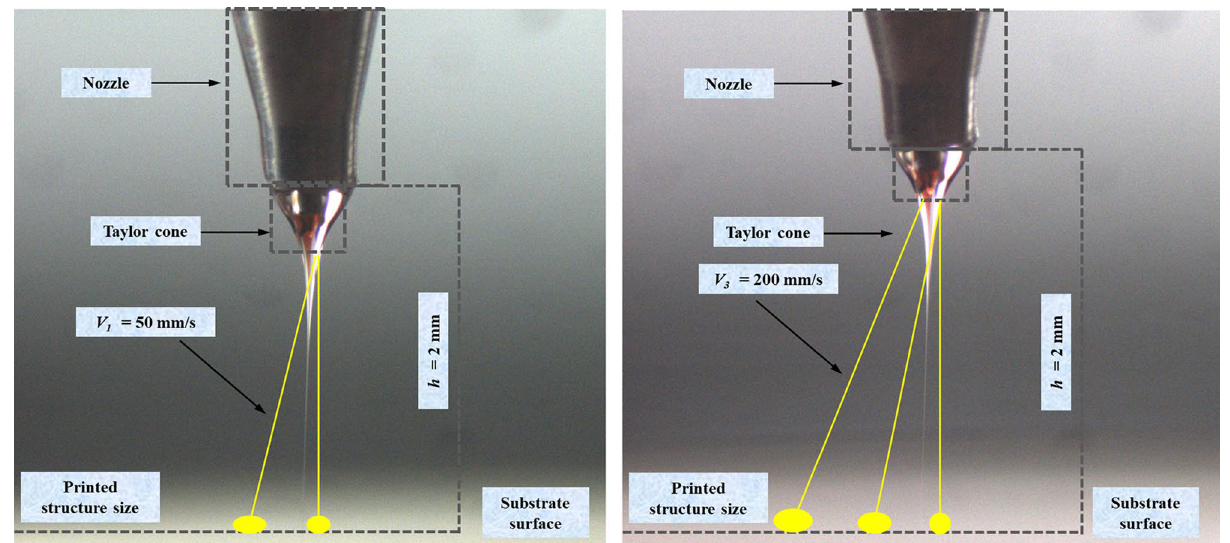
Figure 16. Relation of the substrate speed and the size of printed structures.